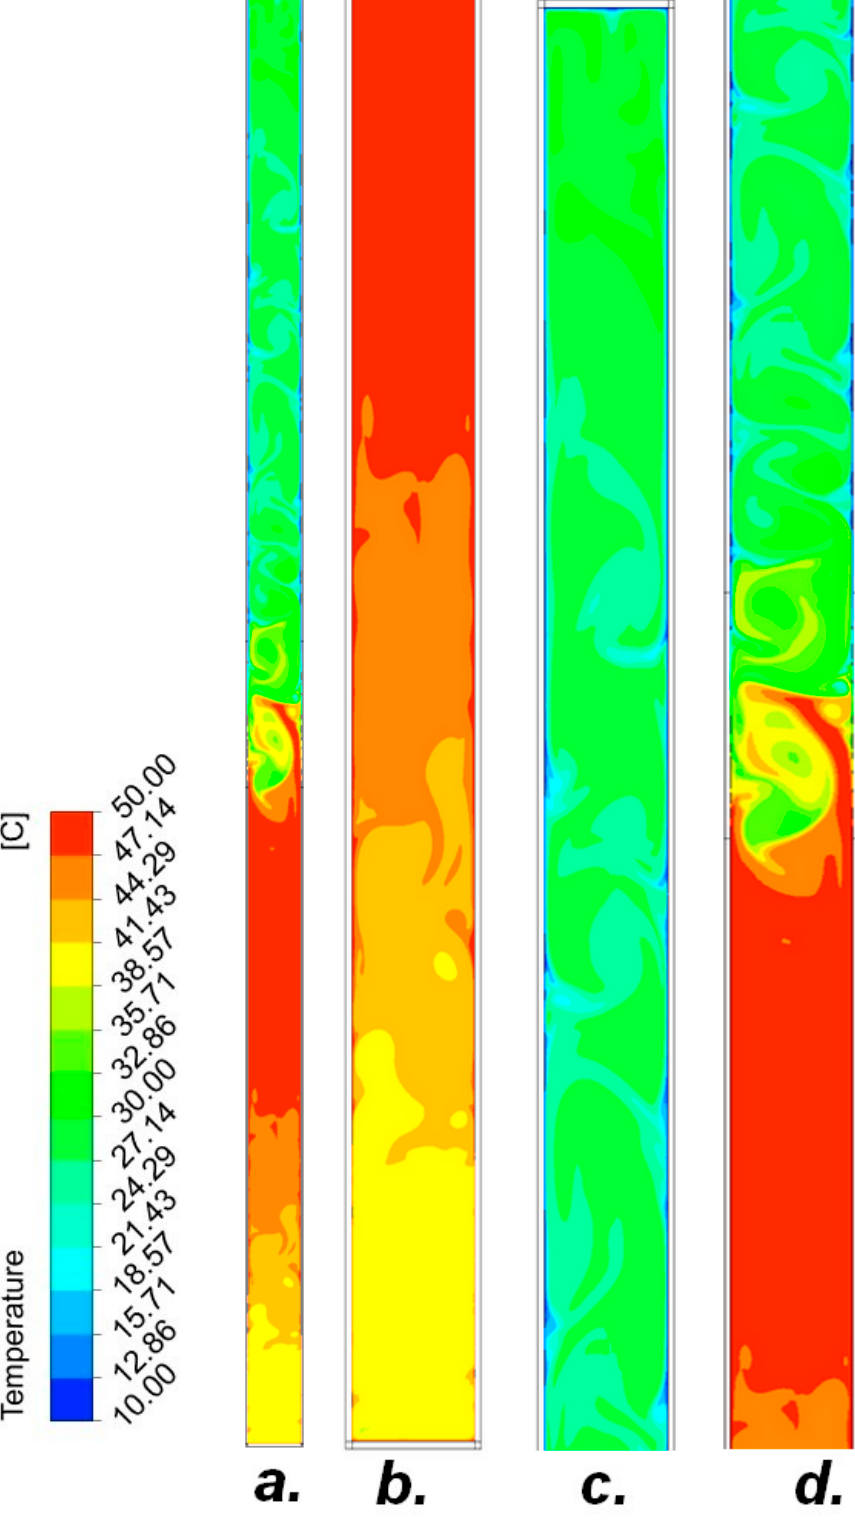
Figure 27. Temperature distribution in the heat pipe. ( a ) Total heat pipe; ( b ) evaporator section; ( c ) condenser section; ( d ) isothermal section.